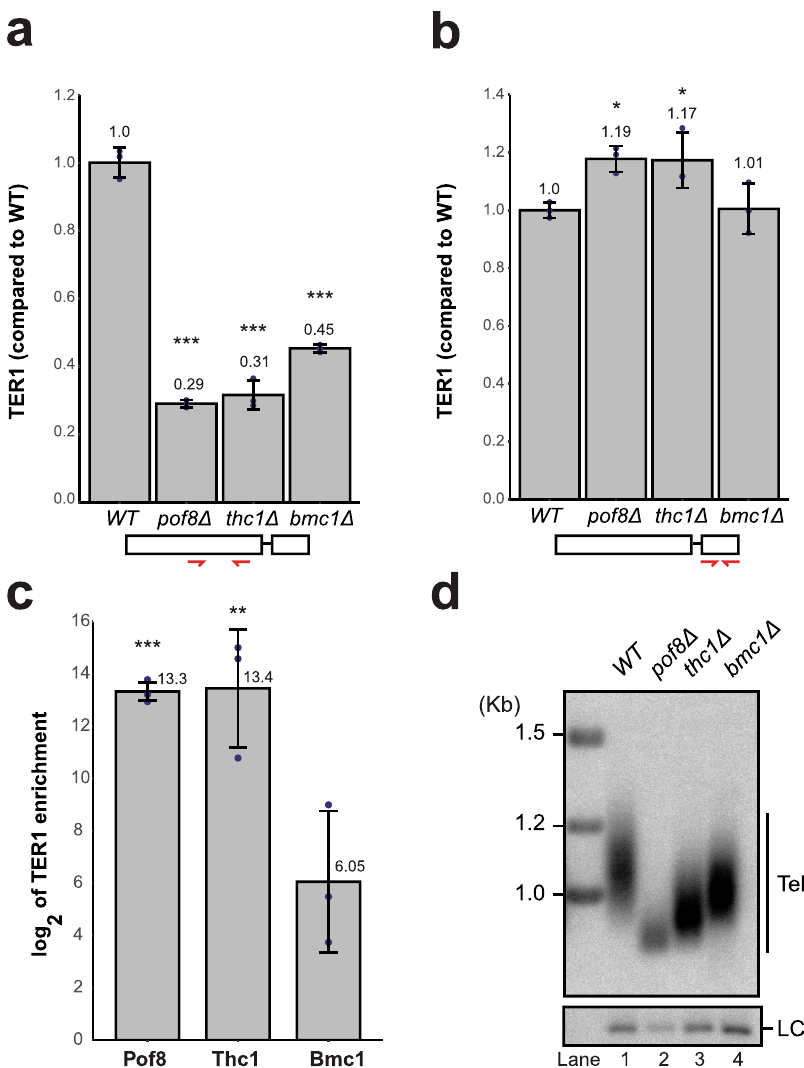
Fig. 3 Thc1 and Bmc1 stabilize TER1 and are required for wild-type telomere length maintenance. a RT-qPCR quanti fi cation of TER1 by from DNase- treated total RNA extracted from wild type (WT), pof8 Δ , thc1 Δ , and bmc1 Δ strains. TER1 was normalized to three endogenous control genes ( act1 , his1 , and snR101 ) and is shown relative to expression in WT. The bars show the mean (±SD, n = 3). Signi fi cant values are marked above each bar (two-sided Dunnett ’ s test; *** p < 0.001, **0.001 ≤ p < 0.01, *0.01 ≤ p < 0.05). The schematic on the bottom indicates the position of the primers (red) used for TER1 ampli fi cation. b RT-qPCR quanti fi cation and statistical analysis as in a but using a primer pair in exon 2 of TER1, which is present in the precursor but not in the mature form of telomerase RNA. c RT-qPCR quanti fi cation of TER1 recovered from immunoprecipitations for 3xFLAG-Pof8, Thc1-2xV5, and Bmc1- Twinstrep normalized to untagged controls. The bars show the mean (±SD, n = 3) of enrichment of TER1 RNA relative to untagged control after normalization to RNA levels in the input using the same primer sets as in a . Statistical analysis as in a . d Telomeric Southern blot using genomic DNA from WT, pof8 Δ , thc1 Δ , and bmc1 Δ strains. Genomic DNA was digested with EcoRI, separated by gel electrophoresis, transferred to a membrane, and probed for telomeric repeats and the rad16 + locus as a loading control biochemical experiments and the identi fi cations of those RNAs in fi ssion yeast that are modi fi ed by Bmc1 and can serve as positive controls for loss of methyltransferase activity.